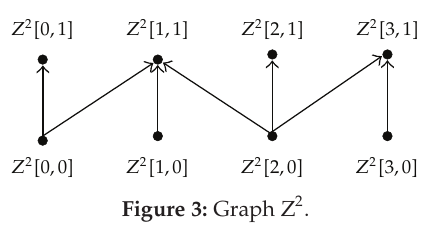
Figure 6 (cid:4) . The two sets of tasks V 1 and V (cid:10) are